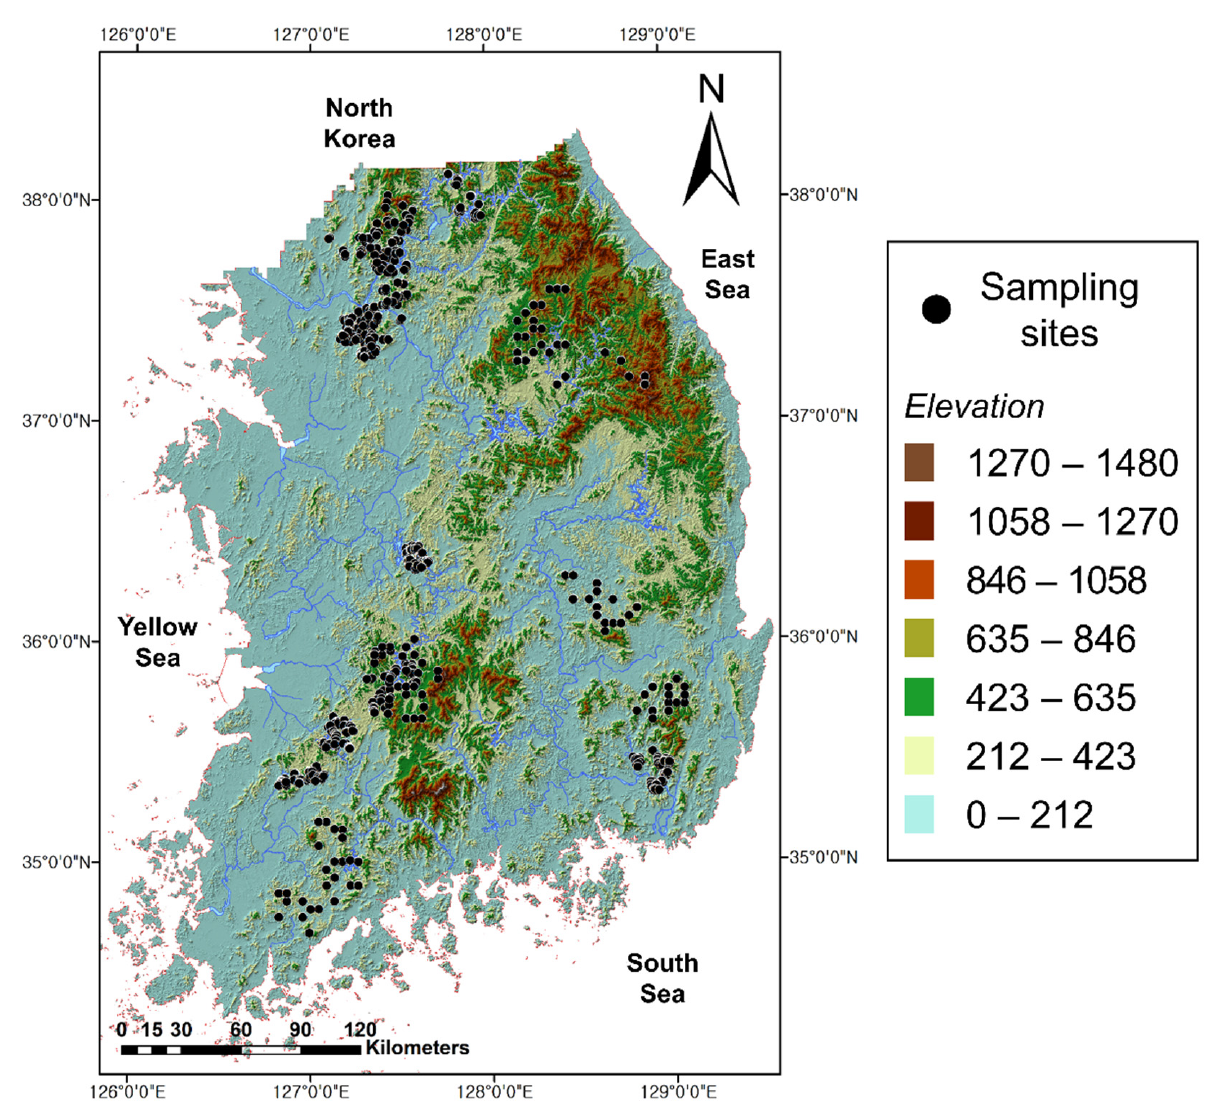
Figure 1. Spatial distribution of 971 soil sampling sites in South Korea.